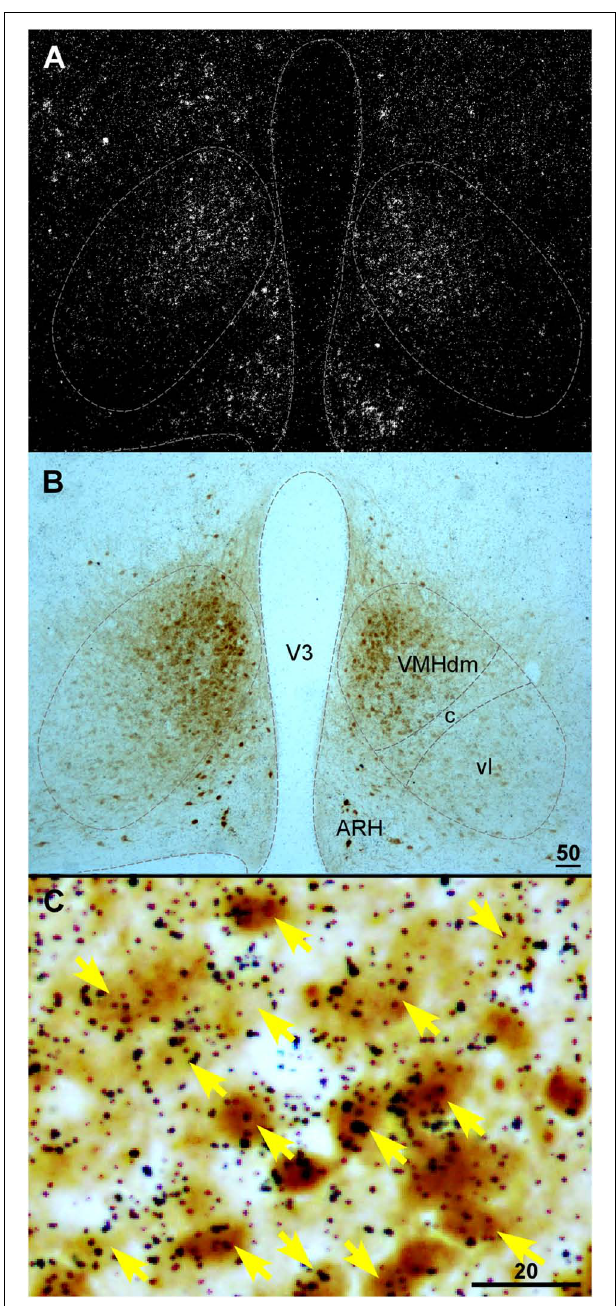
FIGURE 2 | (A) Darkfield photomicrograph showing CRFR2 mRNA signal revealed by in situ hybridization in the basal hypothalamic area of a transgenic mouse expressing Cre recombinase (Cre) and enhanced yellow fluorescent protein (EYFP) in SF1-positive cells. Note that CRFR2 mRNA hybridization signal (white clusters) was abundant in the dorsomedial part of theVMH (VMHdm). (B) Bright field photomicrograph of the same area in (A) showing SF1-positive cells, revealed by immunostaining with anti-green fluorescent protein antibody (darkbrown precipitates) in theVMH. (C) High magnification of boxed area in (A) showing colocalization of CRFR2 (black dot clusters) and SF1 (brown precipitates) in theVMH. ARH, arcuate nucleus of hypothalamus;V3, third ventricle;VMHc, central part of the VMH;VMHdm, dorsomedial part of theVMH;VMHvl, ventrolateral part of theVMH. Scale bar = 50 μ m (B) , 20 μ m (C)